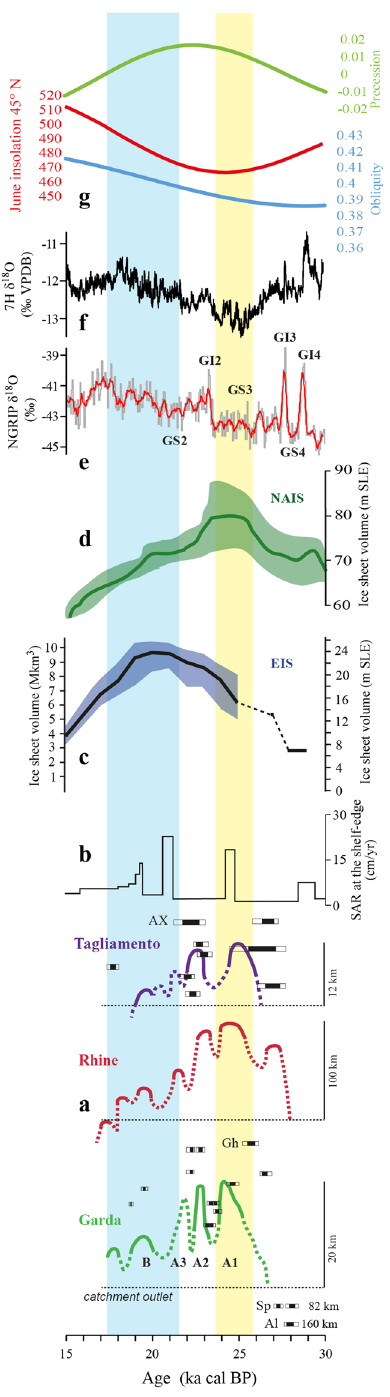
Figure 3. ( a ) Curves representing major culminations (yellow banner) and ice decay (pale-blue banner) of the three considered glaciers relative to the catchment outlet (dashed line) are outlined; datings for Garda catchment 27, 39, 54 and Tagliamento 12 are reported with 2 σ range, (Al: Albeins; AX: Azzano Decimo; Gh: Ghedi; Sp: Spormaggiore). ( b ) Sediment accumulation rate in the Adriatic delta front 38 . ( c ) LGM ice volume of the North American ice sheet (NAIS) 42 . ( d ) LGM ice volume of the Eurasian ice sheet (EIS) 48 . The shaded parts of the curves c and d represent the margins of error in modelling. ( e ) NGRIP δ 18 O 55 . ( f ) 7 H δ 18 O record from speleothem 7H 8 . ( g ) Precession (green), obliquity (blue) and June insolation at 45°N (red) 56